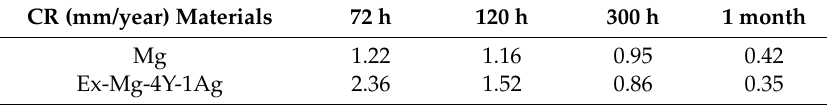
Table 4. The average corrosion rate of Mg and Ex-Mg-4Y-1Ag after 72 h, 120 h, and 300 h of